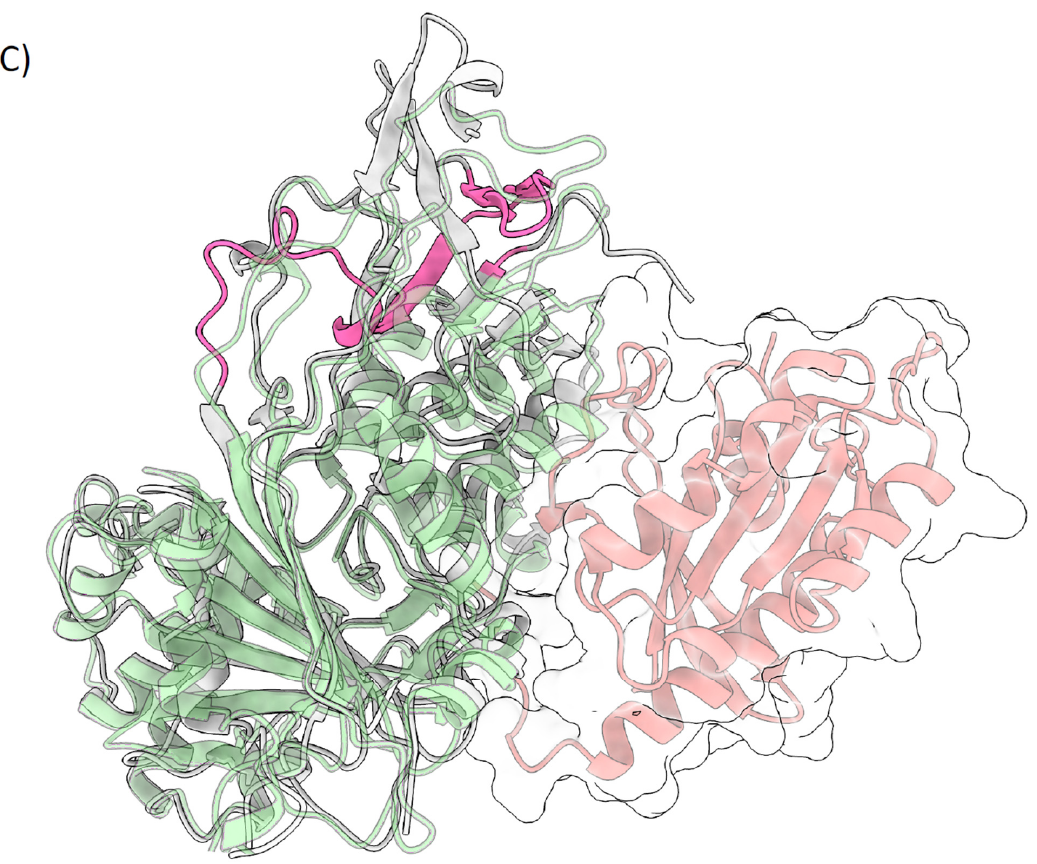
Figure 6. ( A ) The structure of wild type REP1 is shown in grey, with the peptide codified by exon 10 colored in magenta. The interacting RGGT is shown as a deep purple surface, while Rab7 is shown as a pink surface. ( B ) The image shows the interaction lost due to the lack of exon 10 in mutated REP1 (green illustration), while the interaction with RGGT is presumably conserved, given the invariant interaction interface. ( C ) A zoomed view of the interaction with Rab7 (pink illustrations and transparent surface) showing the different interaction interface affecting the binding of Rab7 due to the different conformation of REP1, lacking exon 10